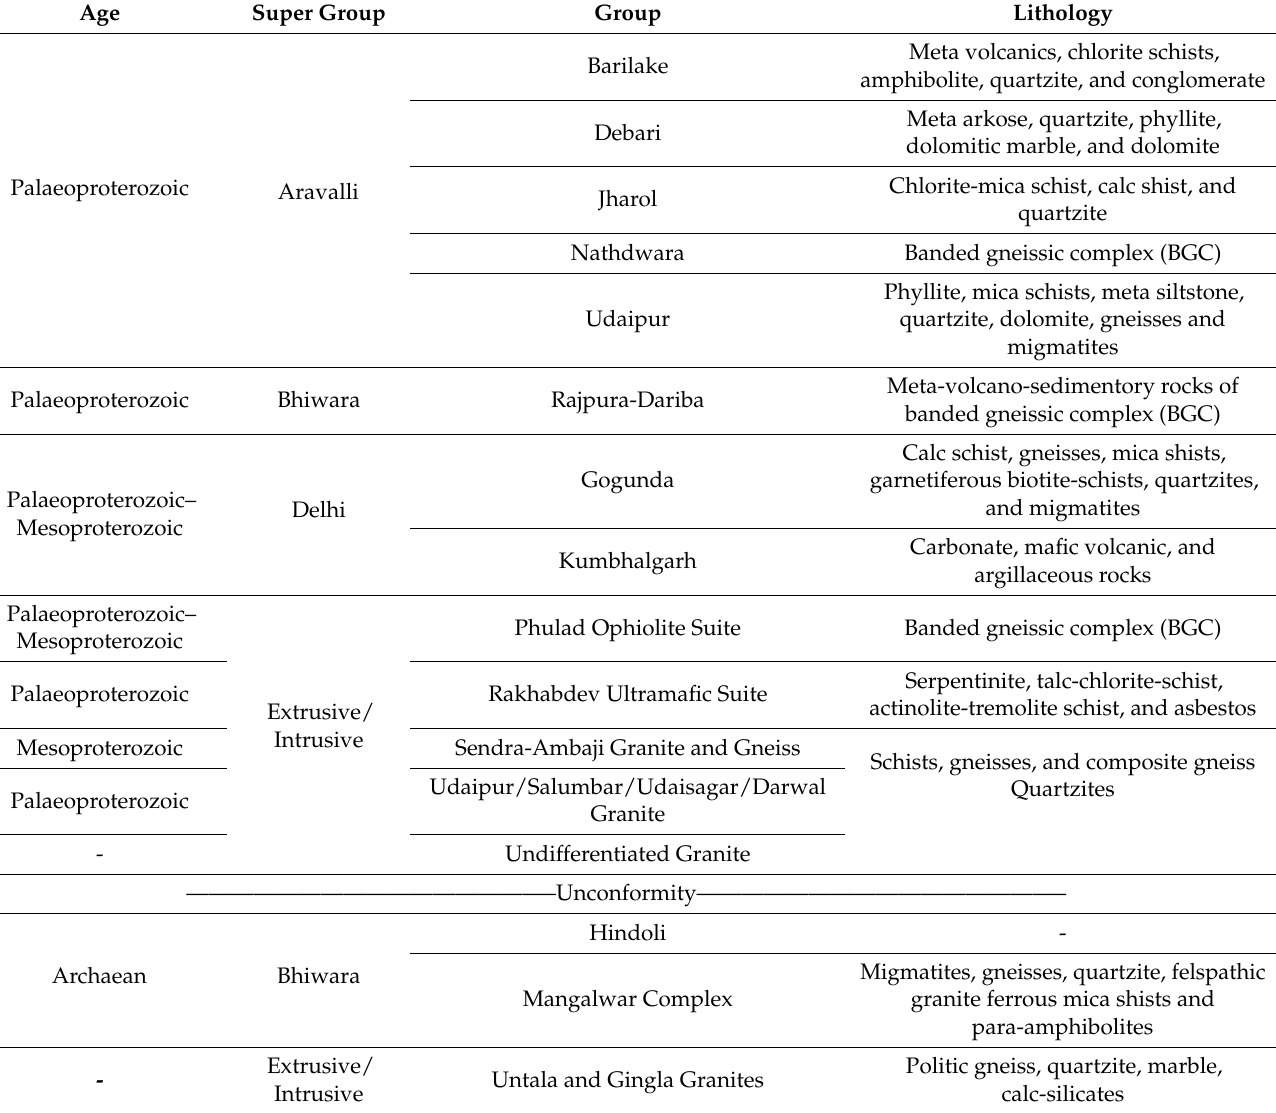
Table 2. Summary of the classes of the stratigraphic geological succession of the study